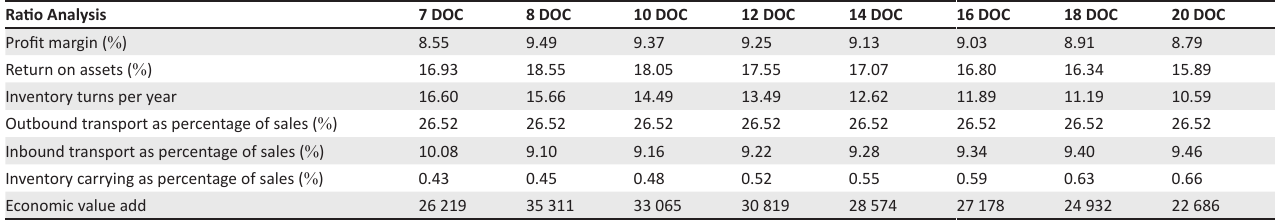
TABLE 6: The financial impact of increased inventory. Ratio Analysis